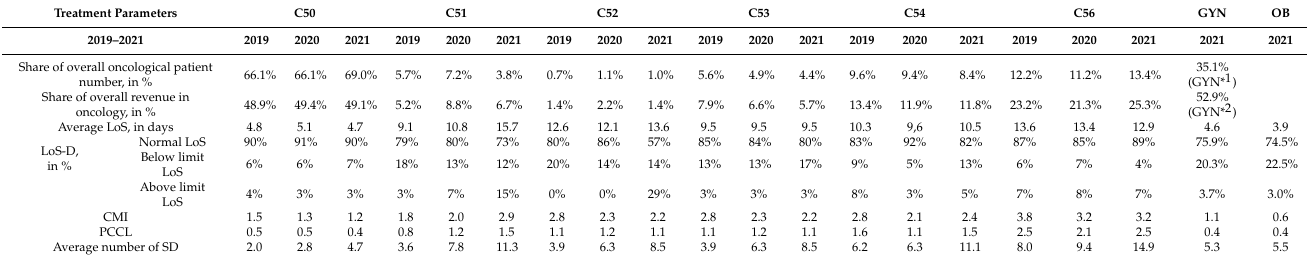
Table 2. Treatment data of the patient collectives and gyne-oncological